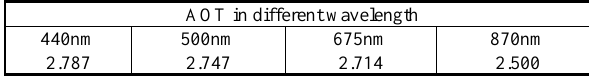
Table 1. AOT measured by MISROTOPS II To demonstrate the effectiveness of the proposed method, results of Schechner was used for comparison. Schechner’ method chose the sky area with the highest luminance value in the image to estimate A and used the sky polarization difference information 